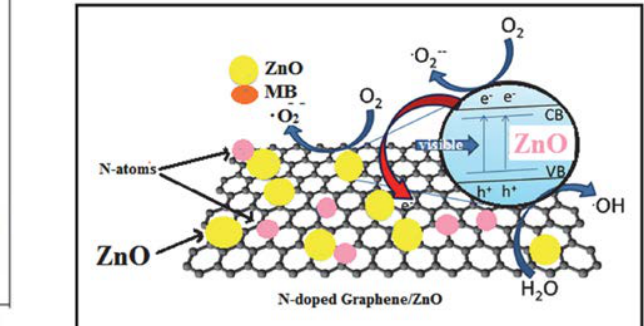
Figure 8. The kinetics of photodegradation of MB.